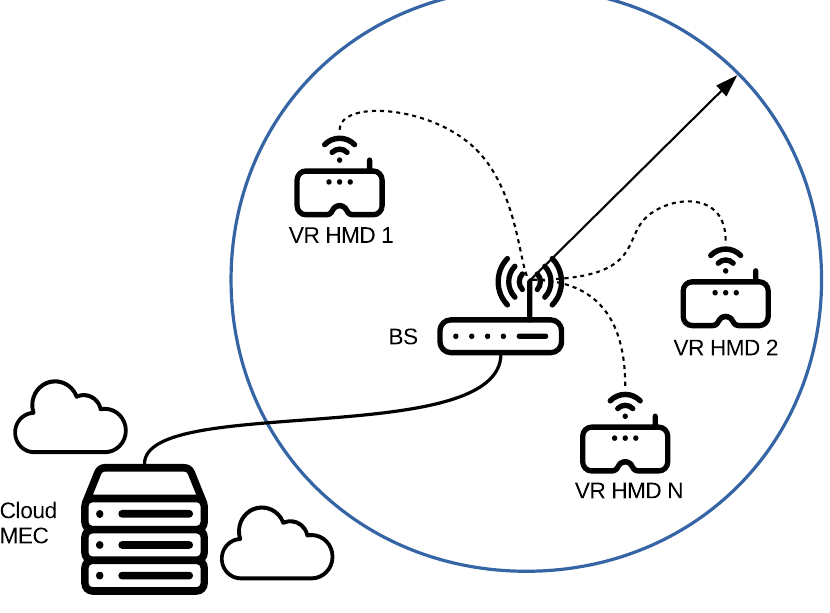
Figure 1. Cloud VR